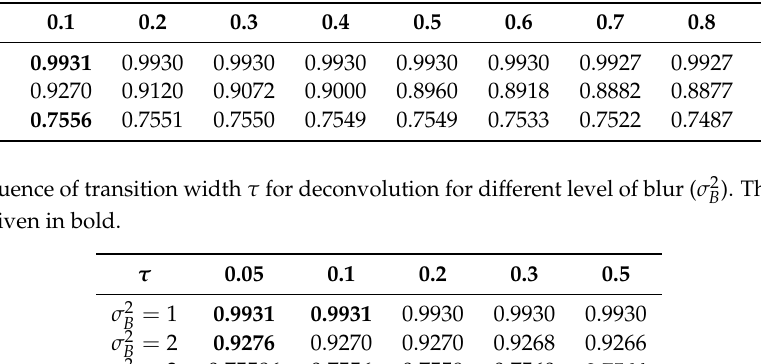
Table 5. Influence of the scale-space step-size s 0 for deconvolution for different level of blur ( σ 2 The best SSIM values are given in bold.